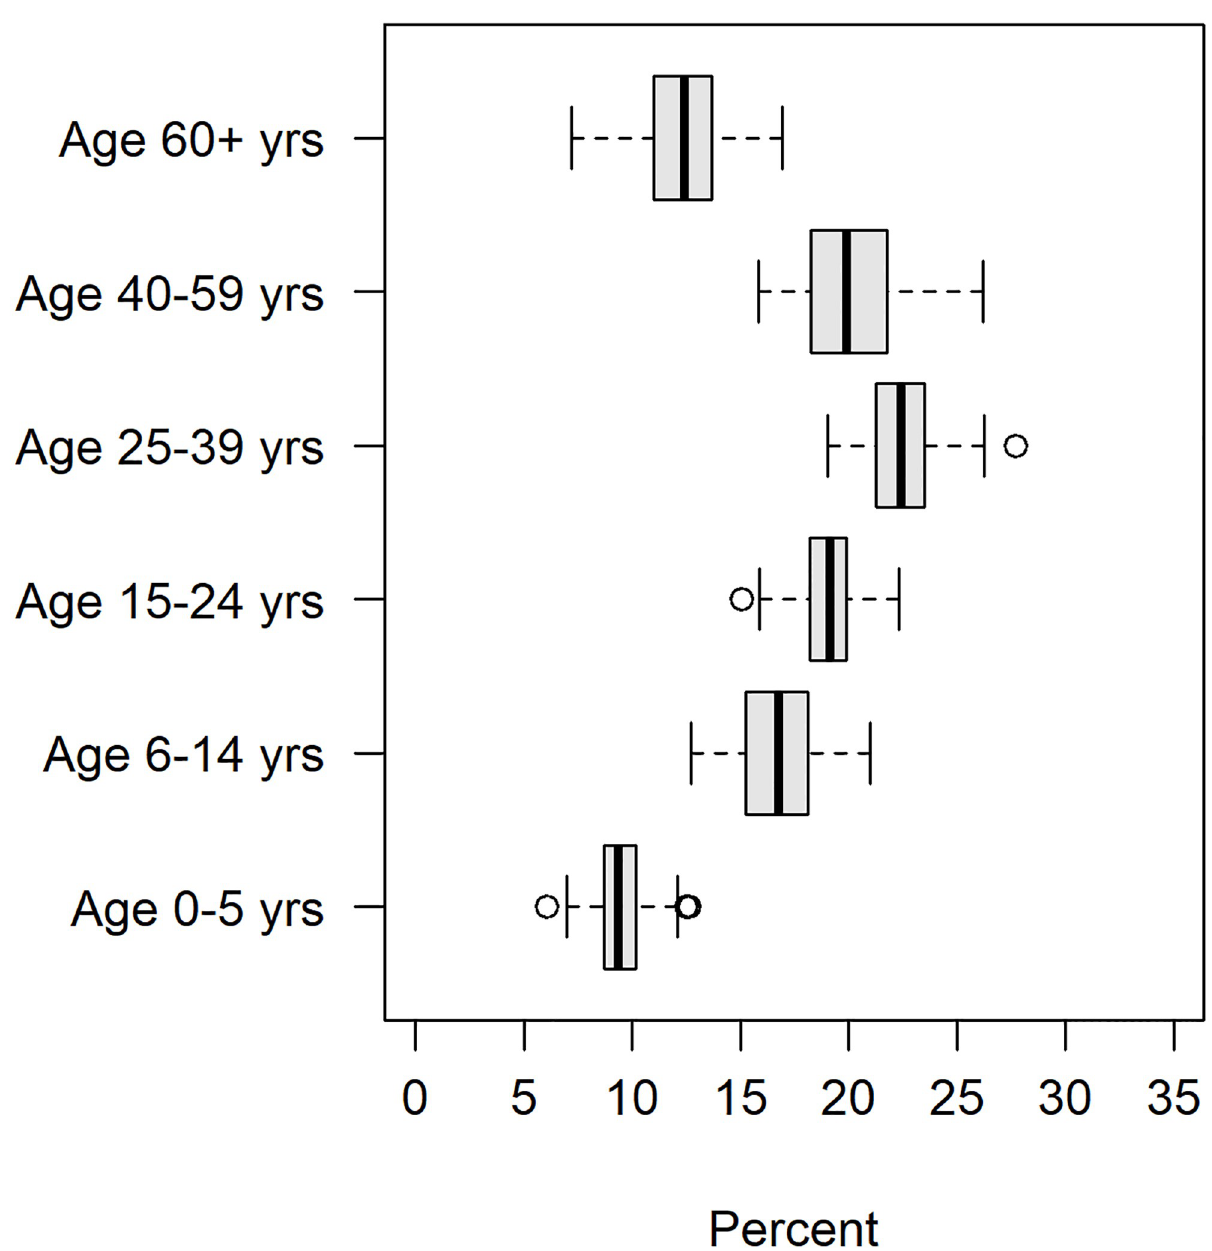
Fig 7. The 2010 Brazilian Federal Census age data was quantified as the percent of individuals within each municipality that fell in each age bracket. The figure above shows the distribution of percentages of residents falling within each age bracket of all RN municipalities.